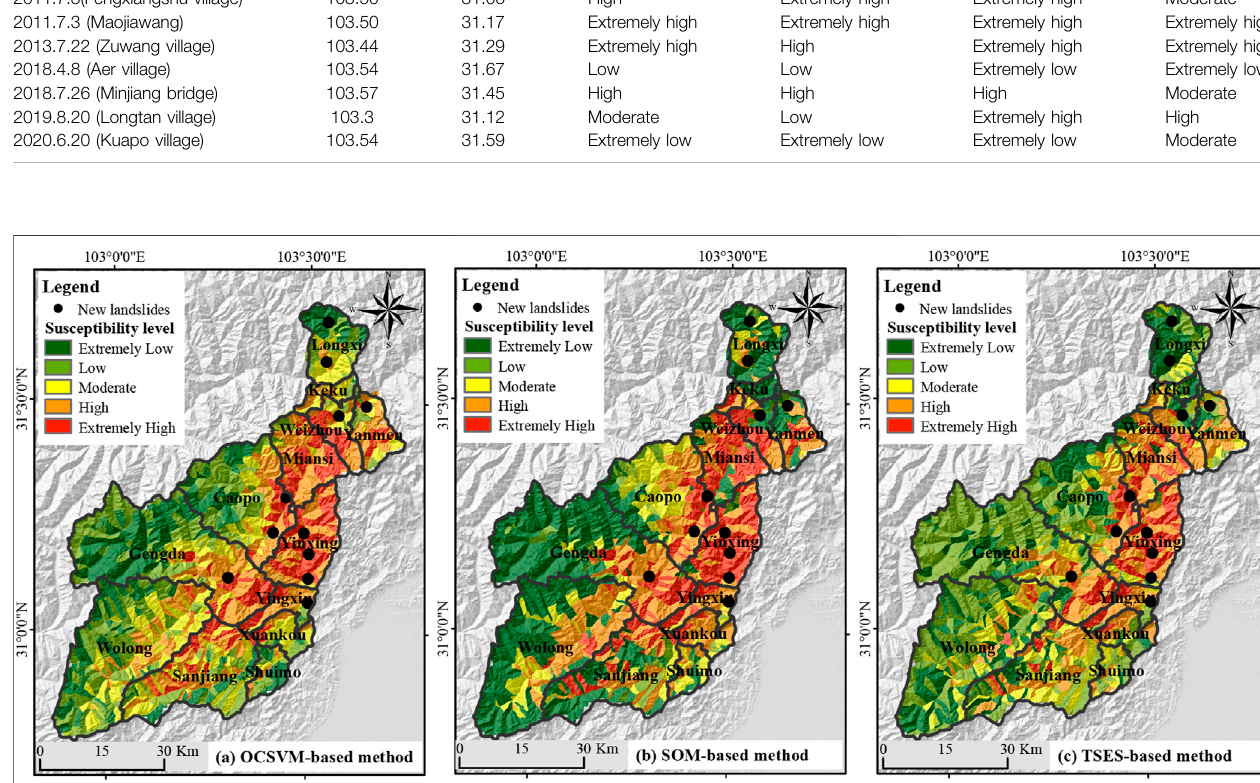
Frontiers in Earth Science |